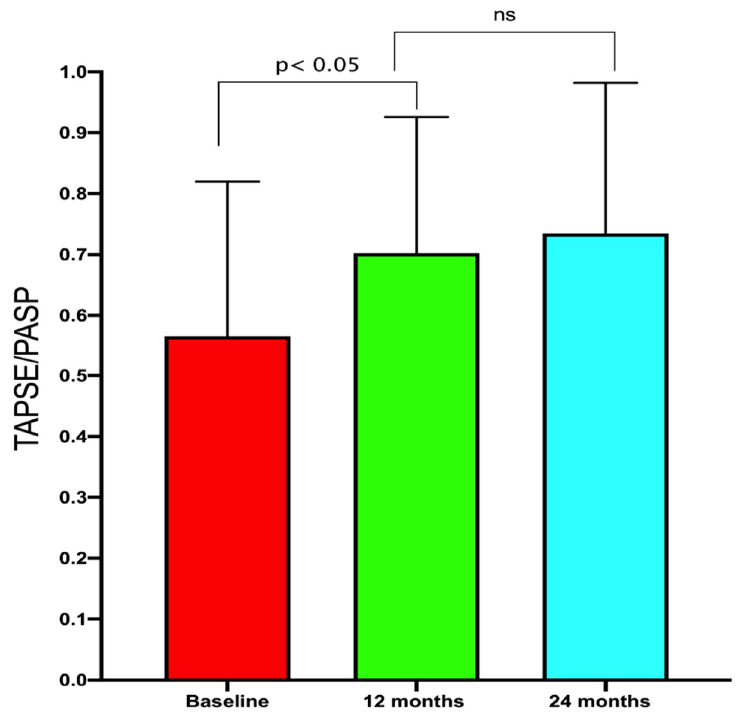
Figure 1. Changes in the TAPSE and PAPS during follow-up. TAPSE—tricuspid annular systolic pressure; PAPS—pulmonary artery systolic pressure.